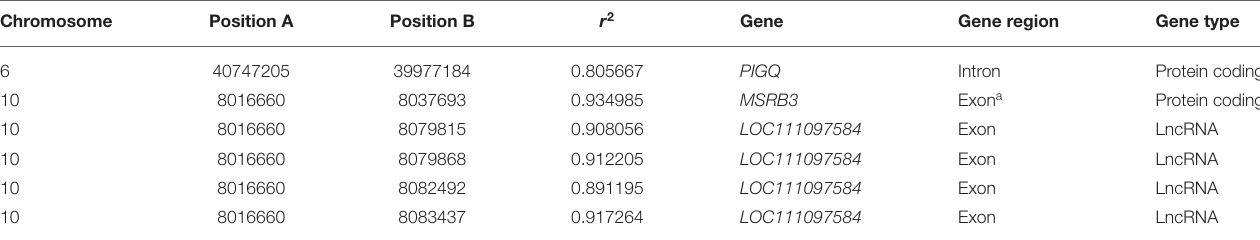
TABLE 3 | Interesting linkage disequilibrium (LD) sites of herding genome-wide association study (GWAS) significant variants with r 2 > 0.8. Chromosome Position A Position B r 2 Gene Gene region Gene type PIGQ Intron Protein coding Exon a Protein